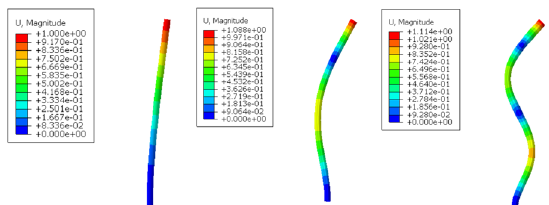
Figure 10 Modal shape of equivalent model of TTM